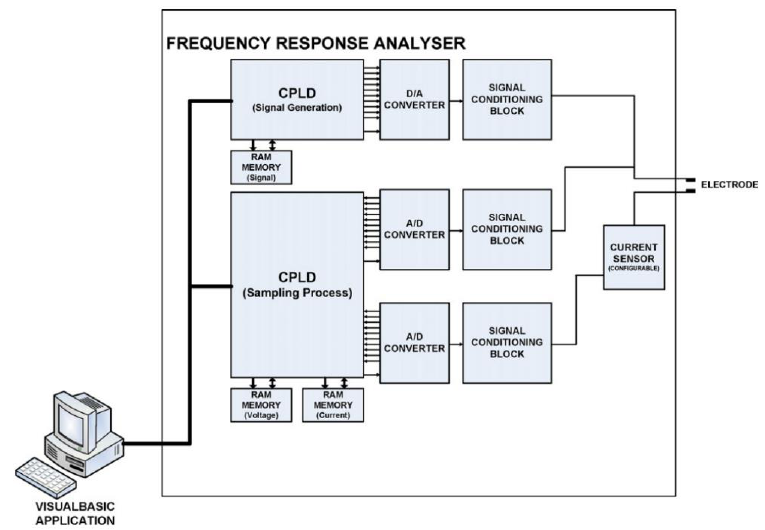
Figure 1. System block diagram of the electrochemical impedance spectroscopy (EIS) device [32]. A/D: analogue-to-digital; D/A: digital-to-analogue.